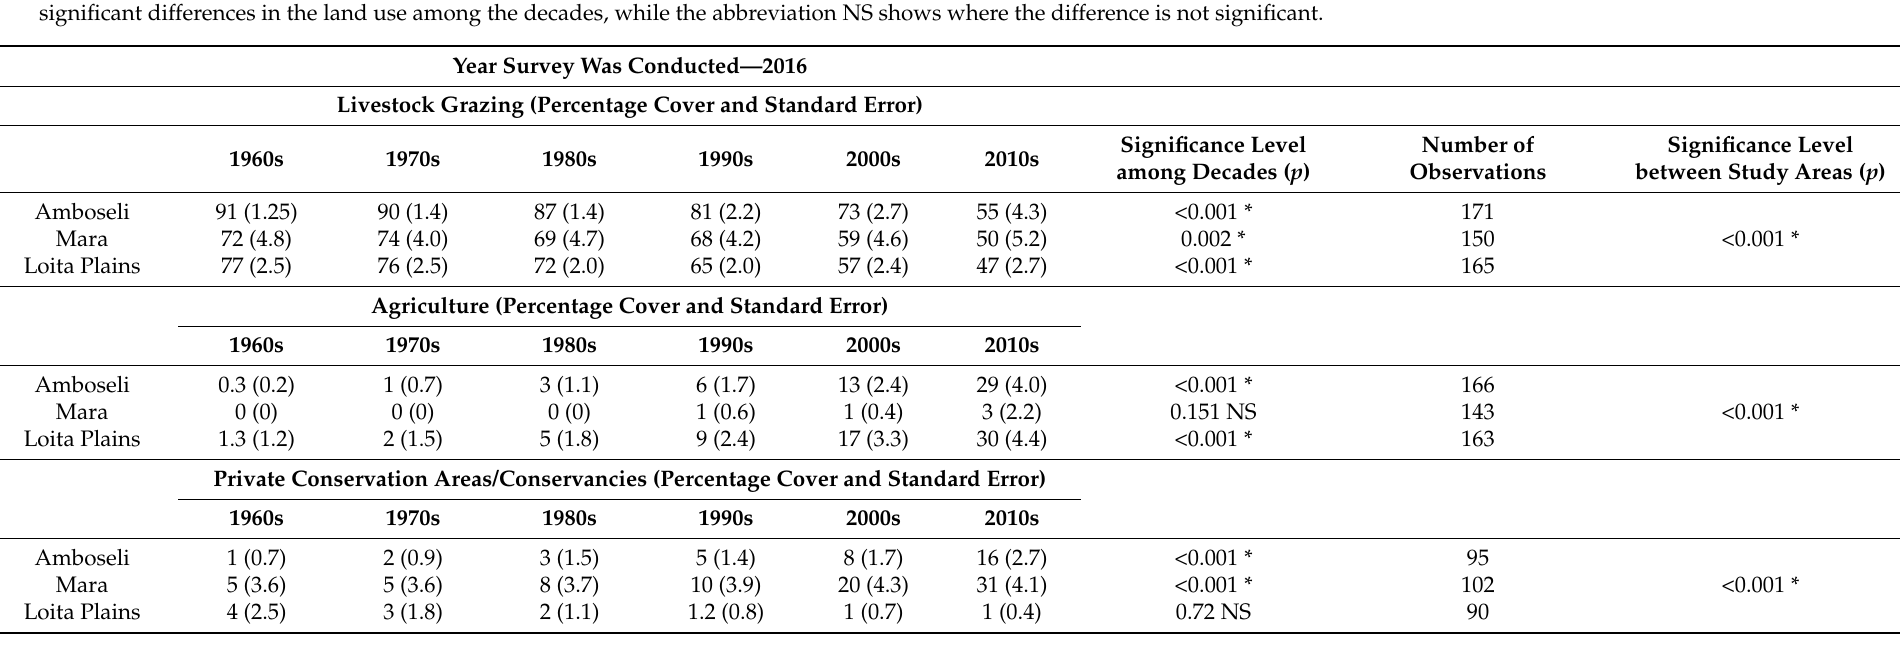
Table 2. Percentage of land (and standard error) used for livestock grazing, agriculture, and private conservation areas/conservancies from 1960s to 2016, as estimated by community leaders in Amboseli, Mara and the Loita Plains. The level of significance comparing land use types across decades in each study area is also included. An asterisk (*) shows where there are significant differences in the land use among the decades, while the abbreviation NS shows where the difference is not